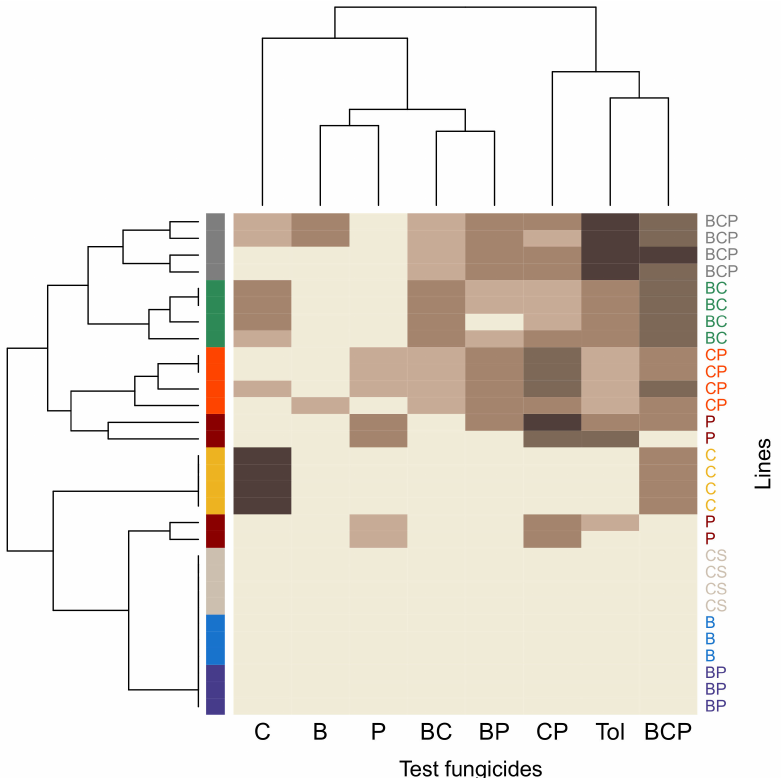
Figure 2. Heatmap of phenotypic resistance profiles at cycle 9. Resistance scores (on the brown scale: from beige = 0 to dark brown = 4) are shown for each of the 12 lines evolved under one of the eight selection regimes (four or three replicate lines per regime; regimes represented by the rainbow scale, as described in Figure 1) and for each fungicide or mixture tested. Names of the lines as in Table 1; CS: control solvent line. Heatmaps were established on the basis of pairwise Euclidean